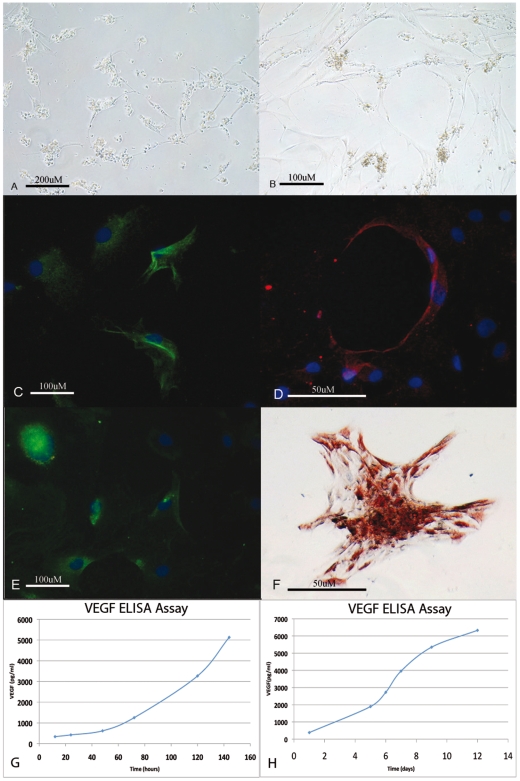
Endothelial differentiation.(A) Image showing differentiated endothelial cells that, after 48 h in methylcellulose, acquire a different morphology comprising round cells with cytoplasmic granules and large flat cells with endothelial morphology (Original magnification 400×); (B) Image showing differentiated endothelial cells that, after day 7 in methylcellulose, formed an extensive intercellular tube networks (Original magnification 400×); Immunofluorescence images of differentiated endothelial cells showing positivity for several specific markers including (C) CD90 (Original magnification 100×); (D) VEGF (Original magnification 100×); (E) CD31 (Original magnification 100×); (F) Immunohistochemistry images of differentiated endothelial cells showing positivity for VEGF (Original magnification 100×); (G) At 140 hours, VEGF quantity was found to be of 5130 pg/ml with respect to the value of 336 pg/ml found at 12 hours; (H) At day 12, VEGF was 6331 pg/ml of medium with respect to 382 pg/ml found at day 1.